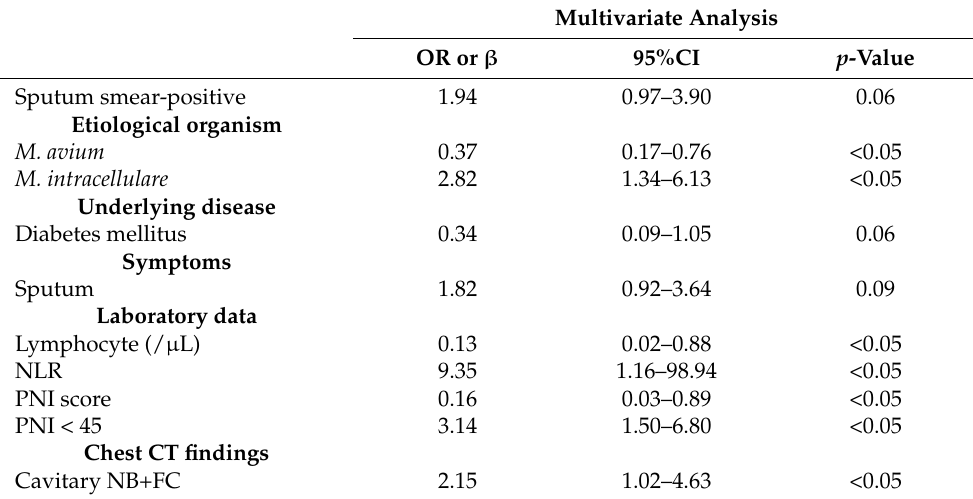
Table 2. Multivariate analysis of the MAC-PD patients with a BMI < 18.5 kg/m 2 .